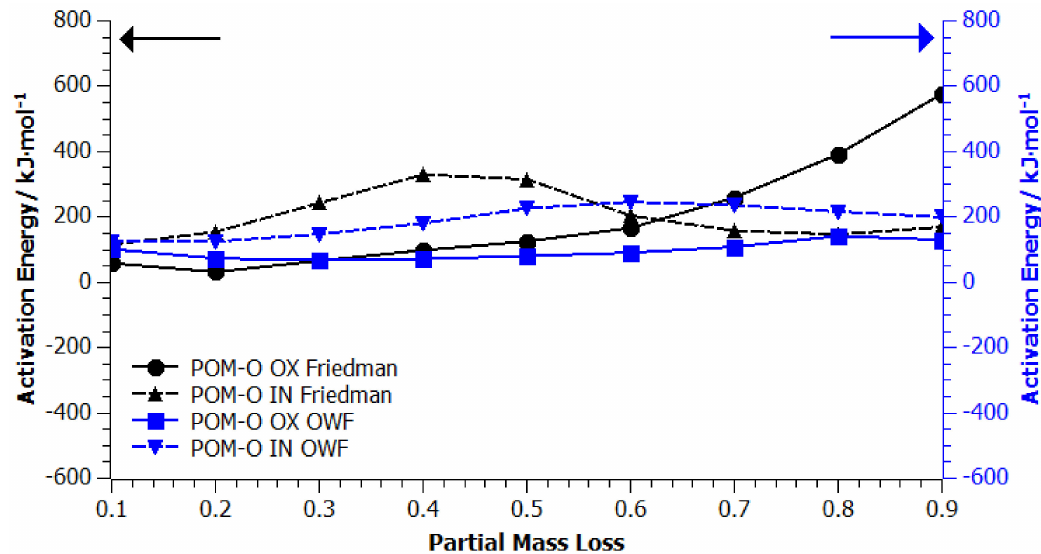
Figure 8. Apparent activation energy vs. partial mass loss found from the slope of isoconversion lines from Friedman (black lines) and OWF (blue lines) analyses of POM-O plots, where OX stands for tests carried out in an oxidizing atmosphere and IN in an inert